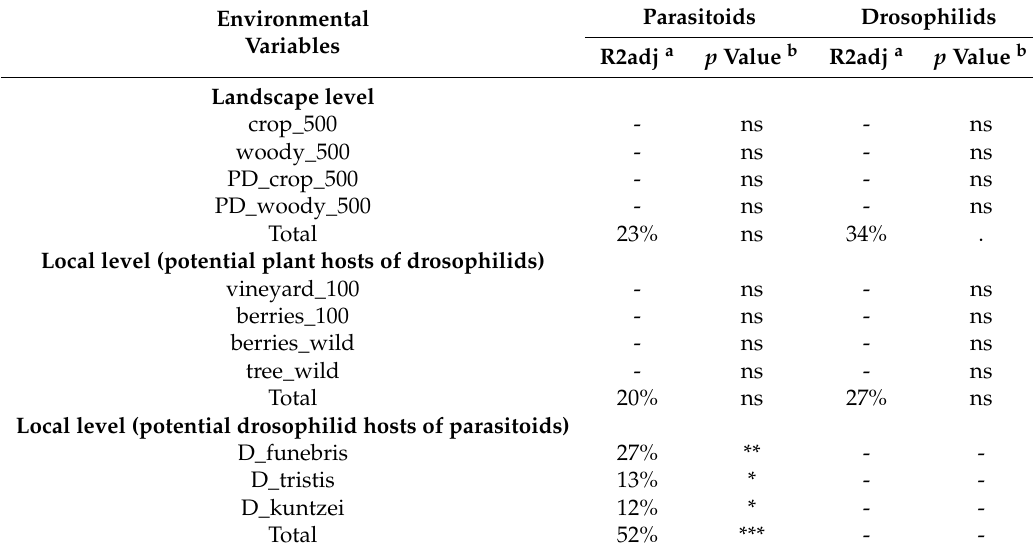
Table 4. Results of separate RDA analyses performed to test for e ff ect of landscape- and local level variables on the community composition of both parasitoids and drosophilids in Ticino in